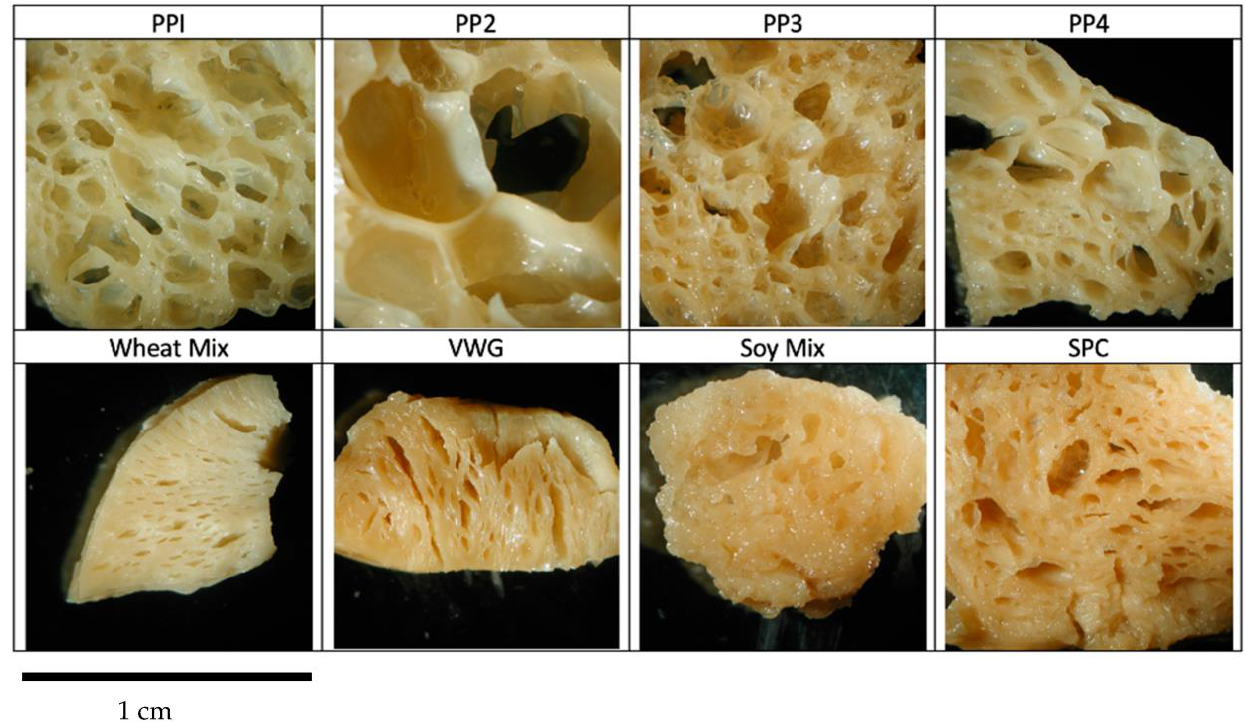
Figure 11. Horizontal cross sections of whole extrudate pieces. Horizontal cross sections are cut against the direction of flow from the extruder. Each image is approximately 1 cm across.